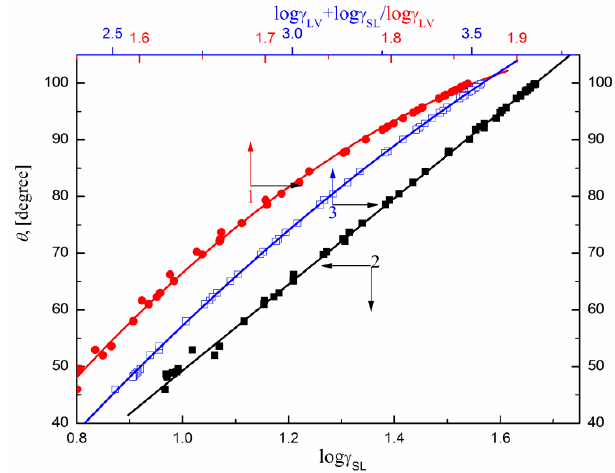
Figure 7. A plot of the contact angle ( θ ) of the aqueous solution of SMD and SML on the PE surface vs. the surface tension of solution ( γ LV ) (curve 1), PTFE–solution interface tension ( γ SL ) (curve 2) and SLLV loglog (curve 3).